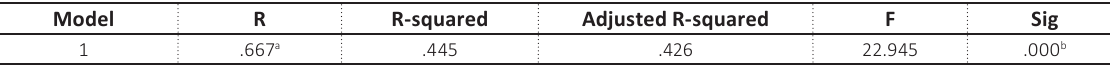
Table 5. Multiple regression showing the joint influence of minimum wage, prompt salary payment, and demographic factors on teacher